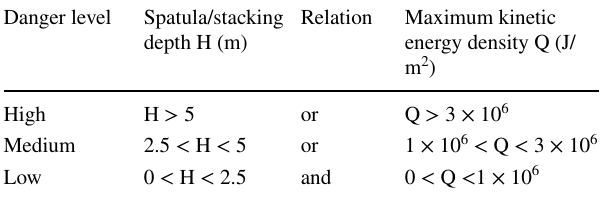
Table 1 Classification of hazard levels